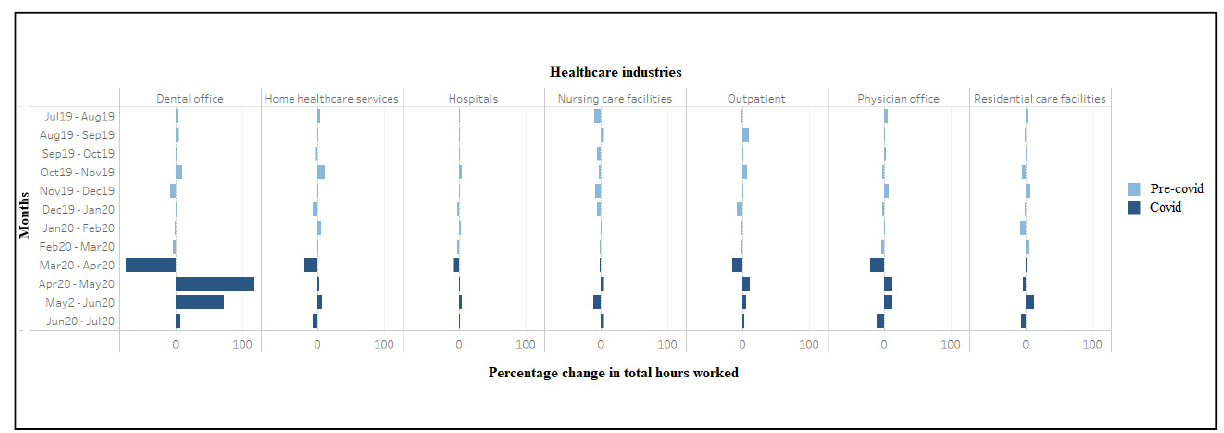
Figure A1. Percentage change in total hours worked by workers in healthcare industries (July 2019–2020). Int. J. Environ. Res. Public Health 2021 , 18 , x FOR PEER REVIEW